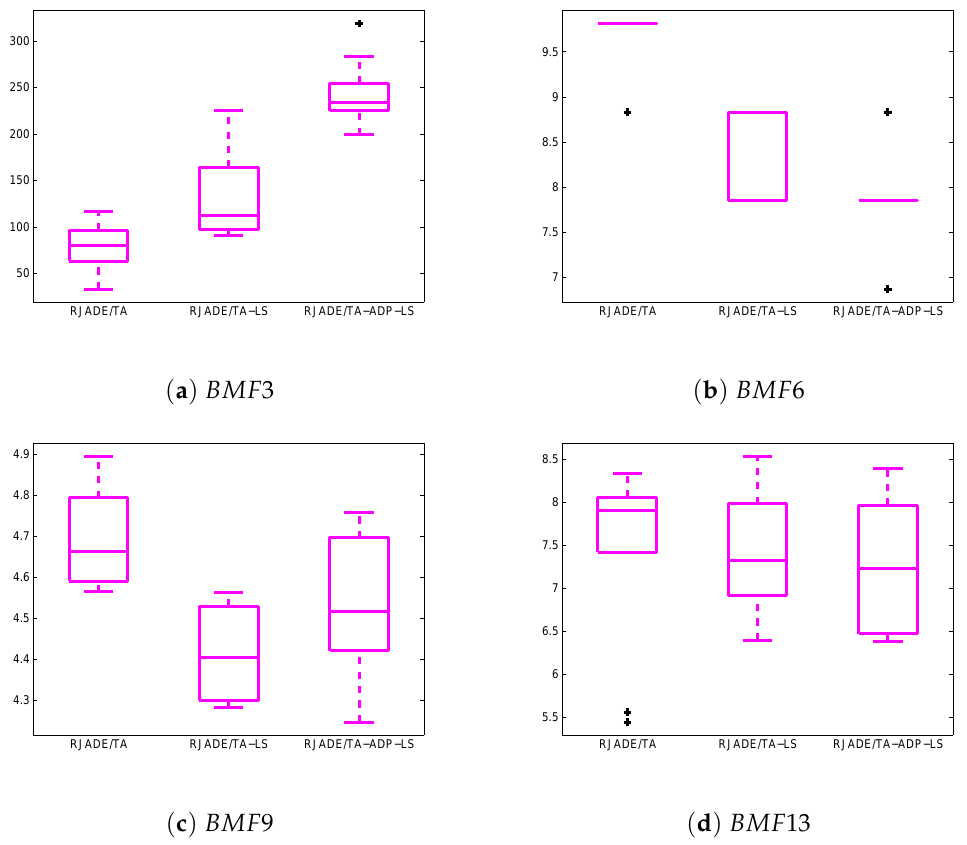
Figure 2. Box plots of various algorithms in